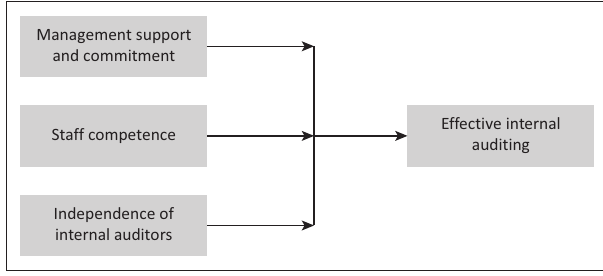
FIGURE 1: Conceptual framework for the